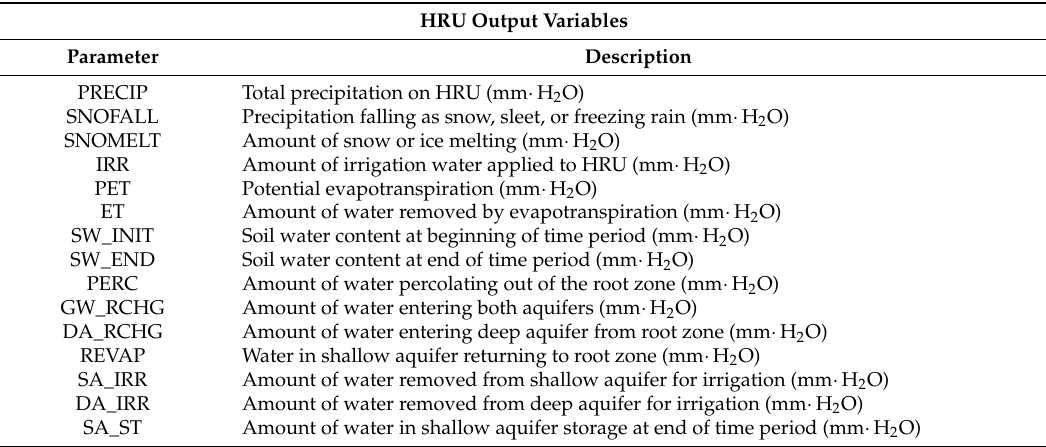
Table C3. Printable SWAT variables for HRU